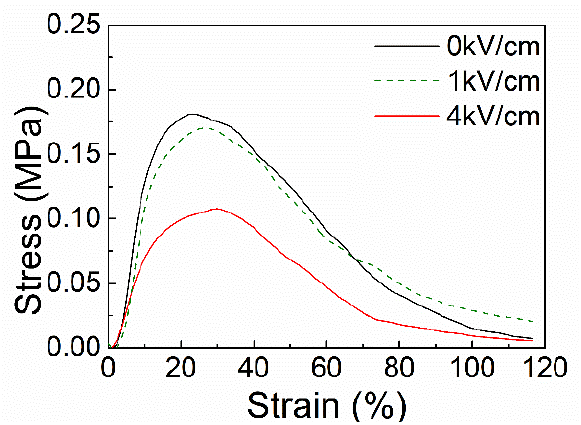
Figure 5. Stress-strain curve of electrostatic-assisted melt-blown fabric and conventional melt-blown fabric.